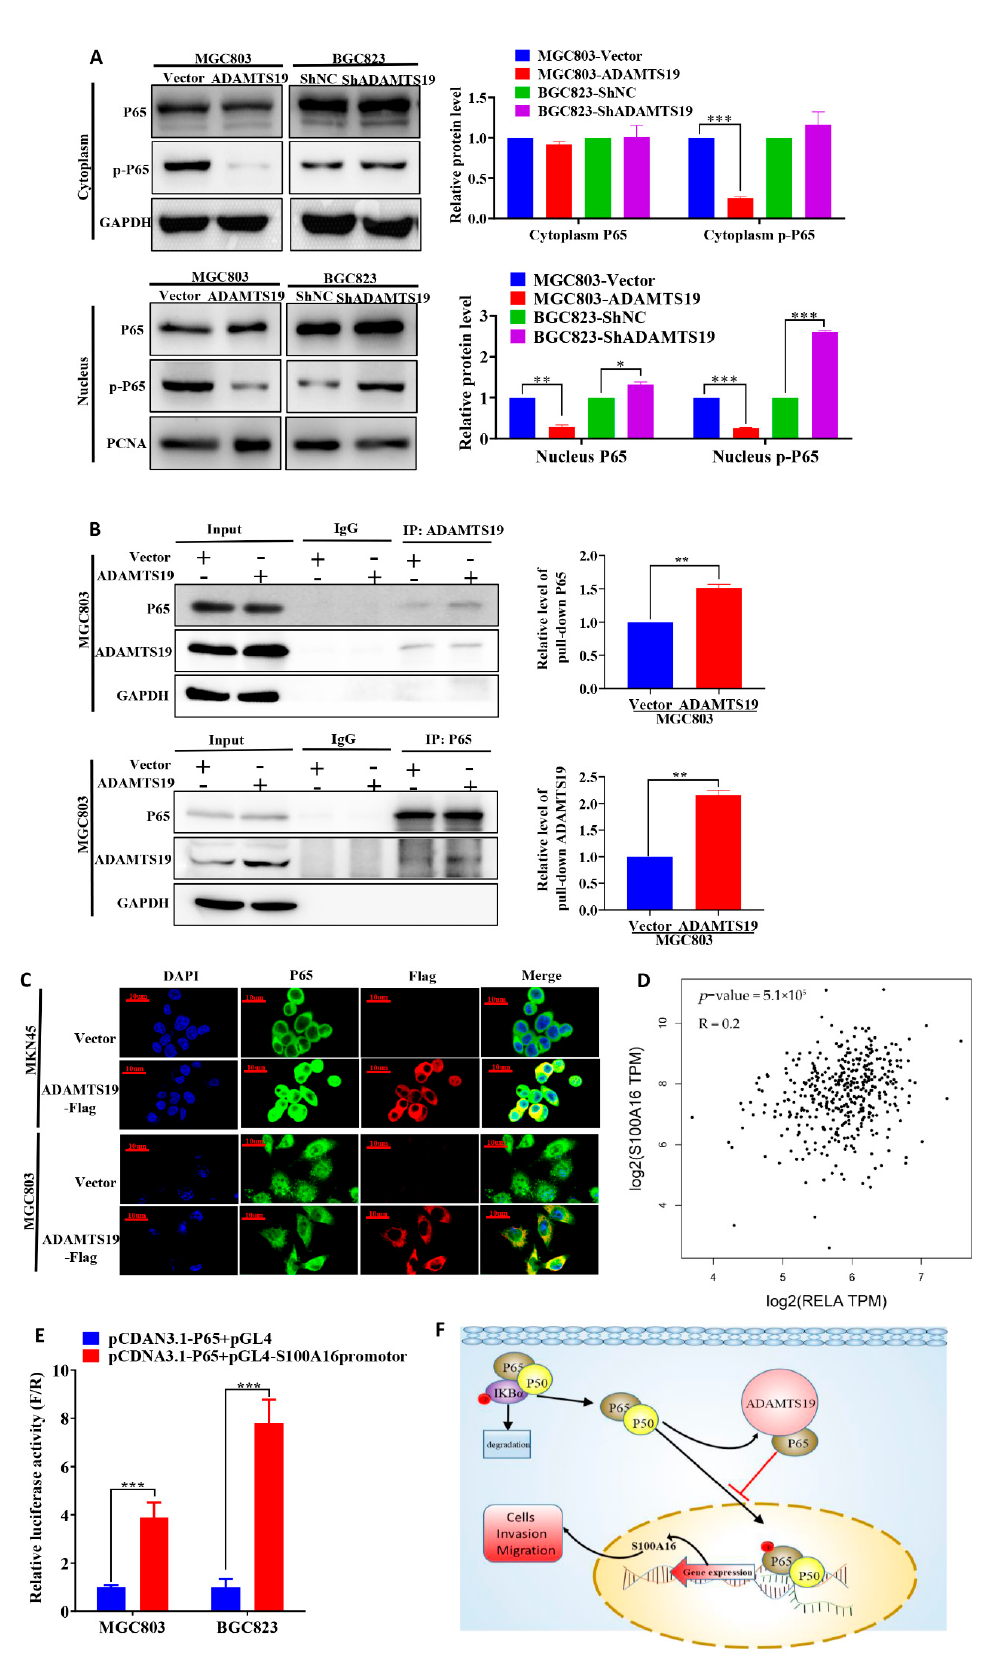
Figure 4. ADAMTS19 downregulates S100A16 by participating in the process of P65 phosphorylation of the NF- κ B